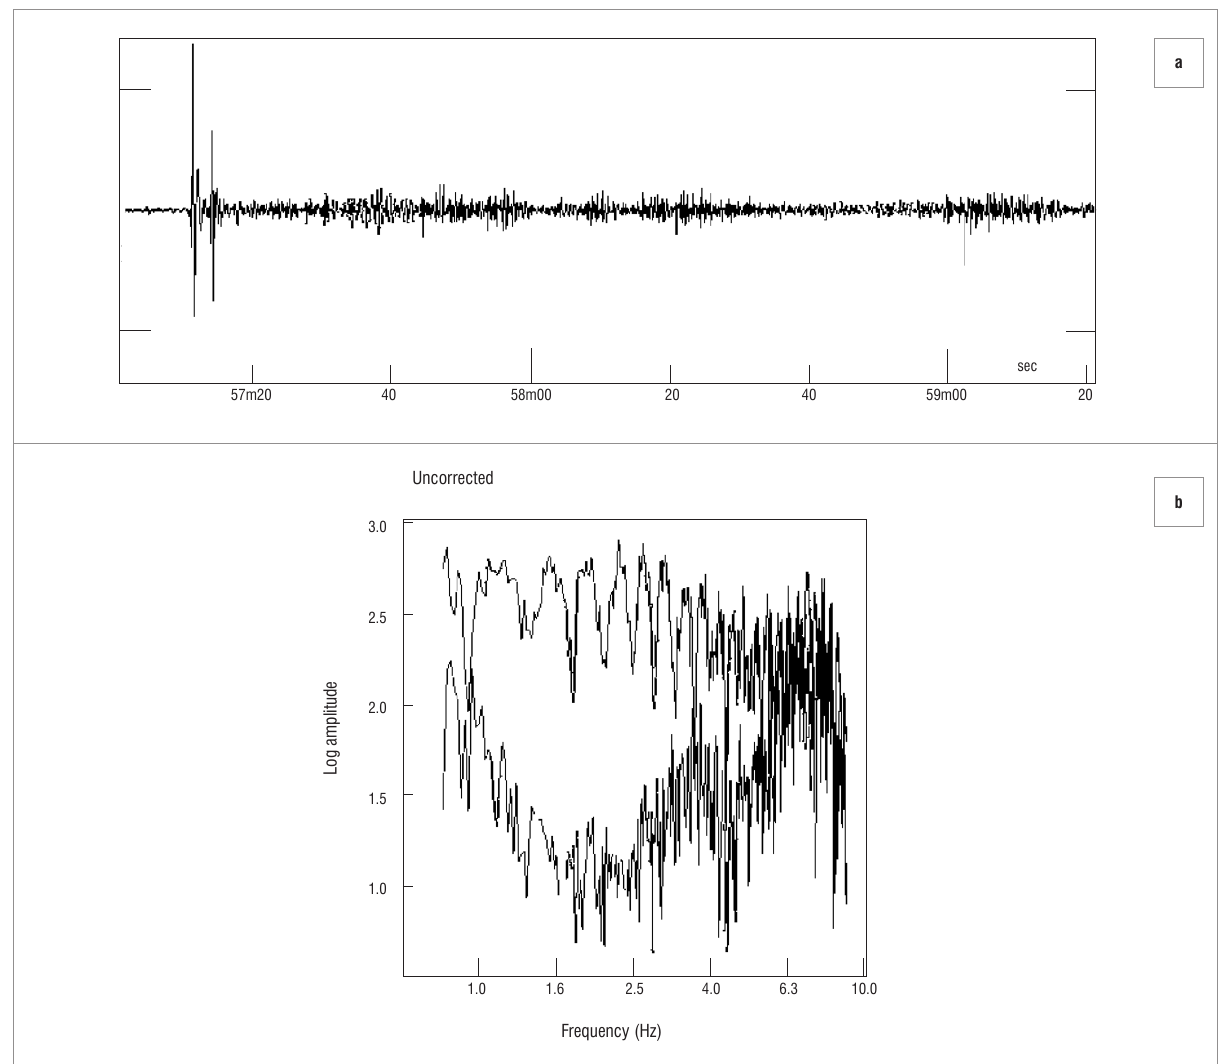
Figure 5: Detailed view of signal S2 showing (a) the time series and (b) the spectra of the